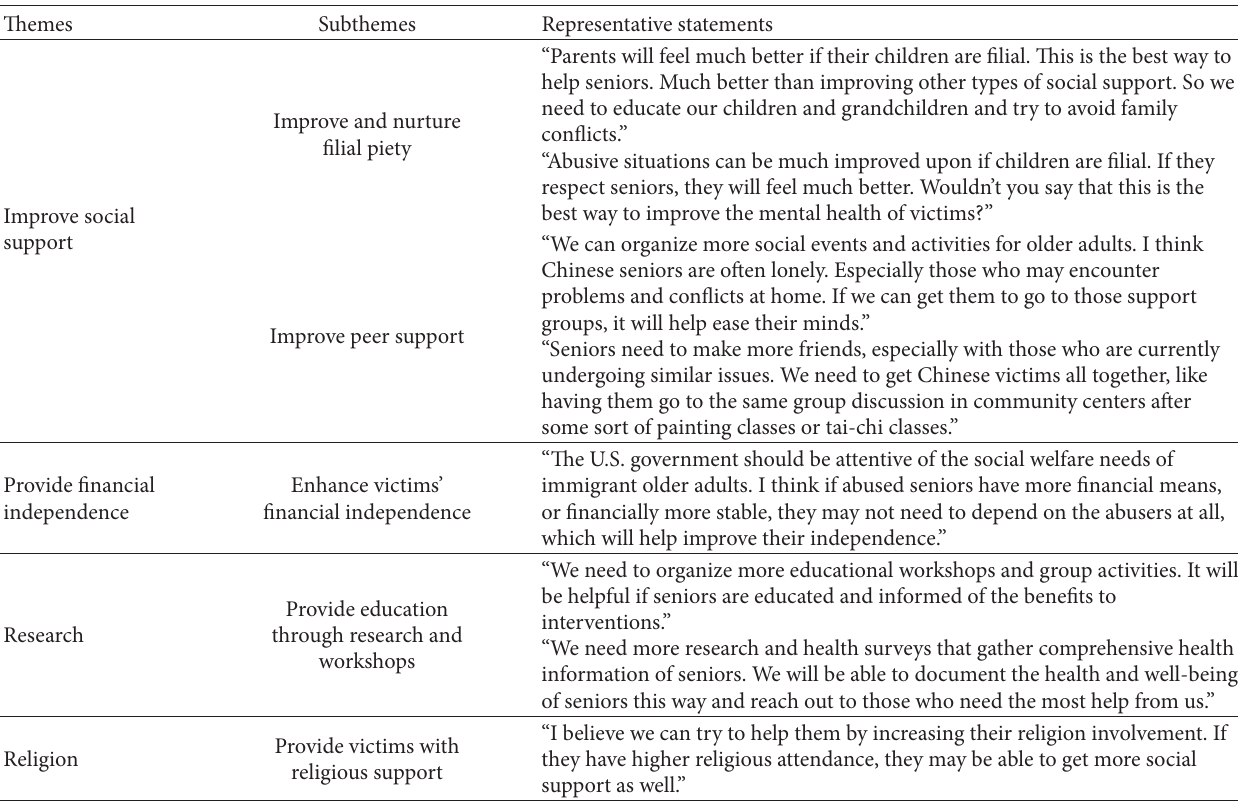
Table 5: Strategies to culturally adapt elder abuse interventions in the chinese